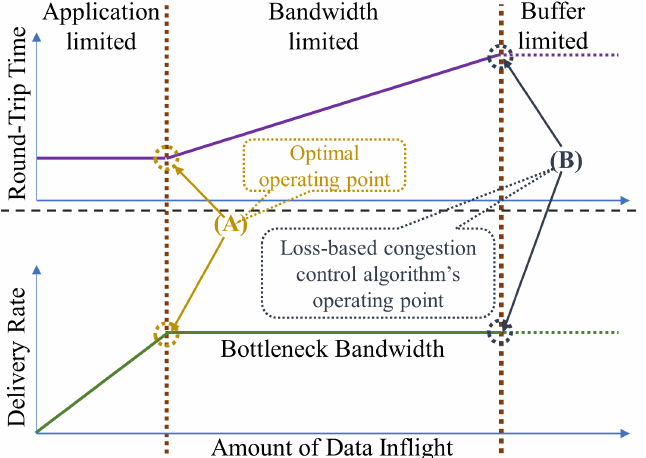
Figure 1. Relationship of delivery rate and round-trip time with the amount of inflight data, and the operating points of the congestion control algorithms according to